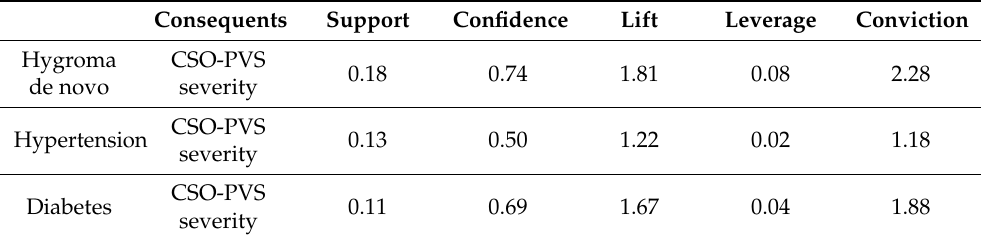
Table 2. Association rule mining analysis of the relationship between CSO-PVS severity and other risk factors.